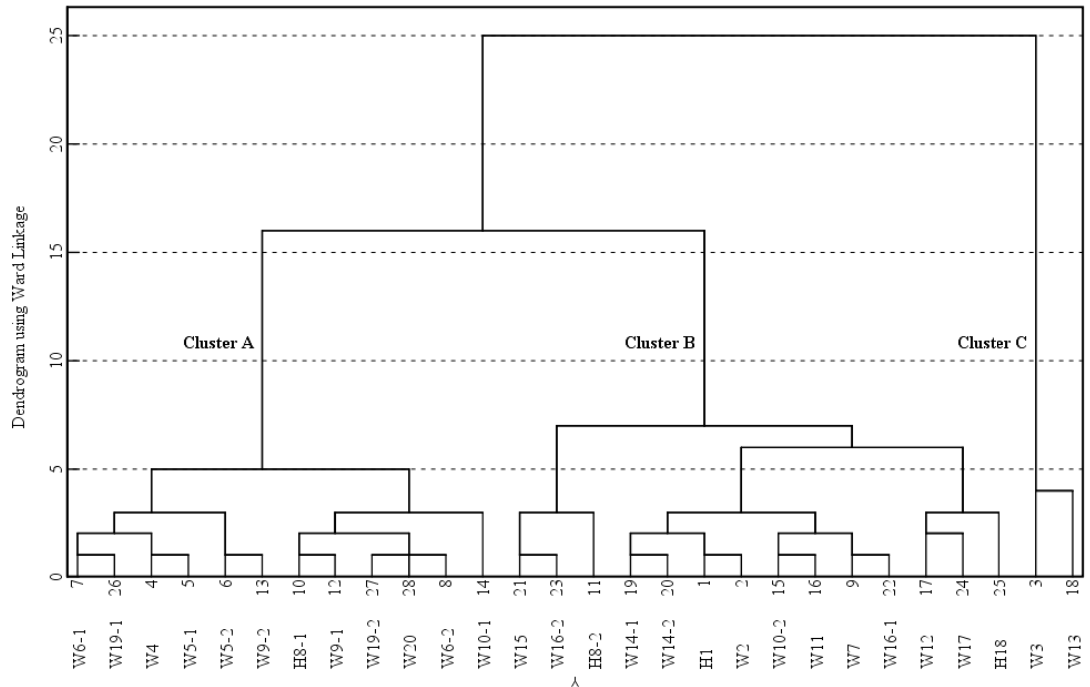
Figure 6. Dendrogram of Q-model hierarchical cluster analysis (HCA) including all water samples.